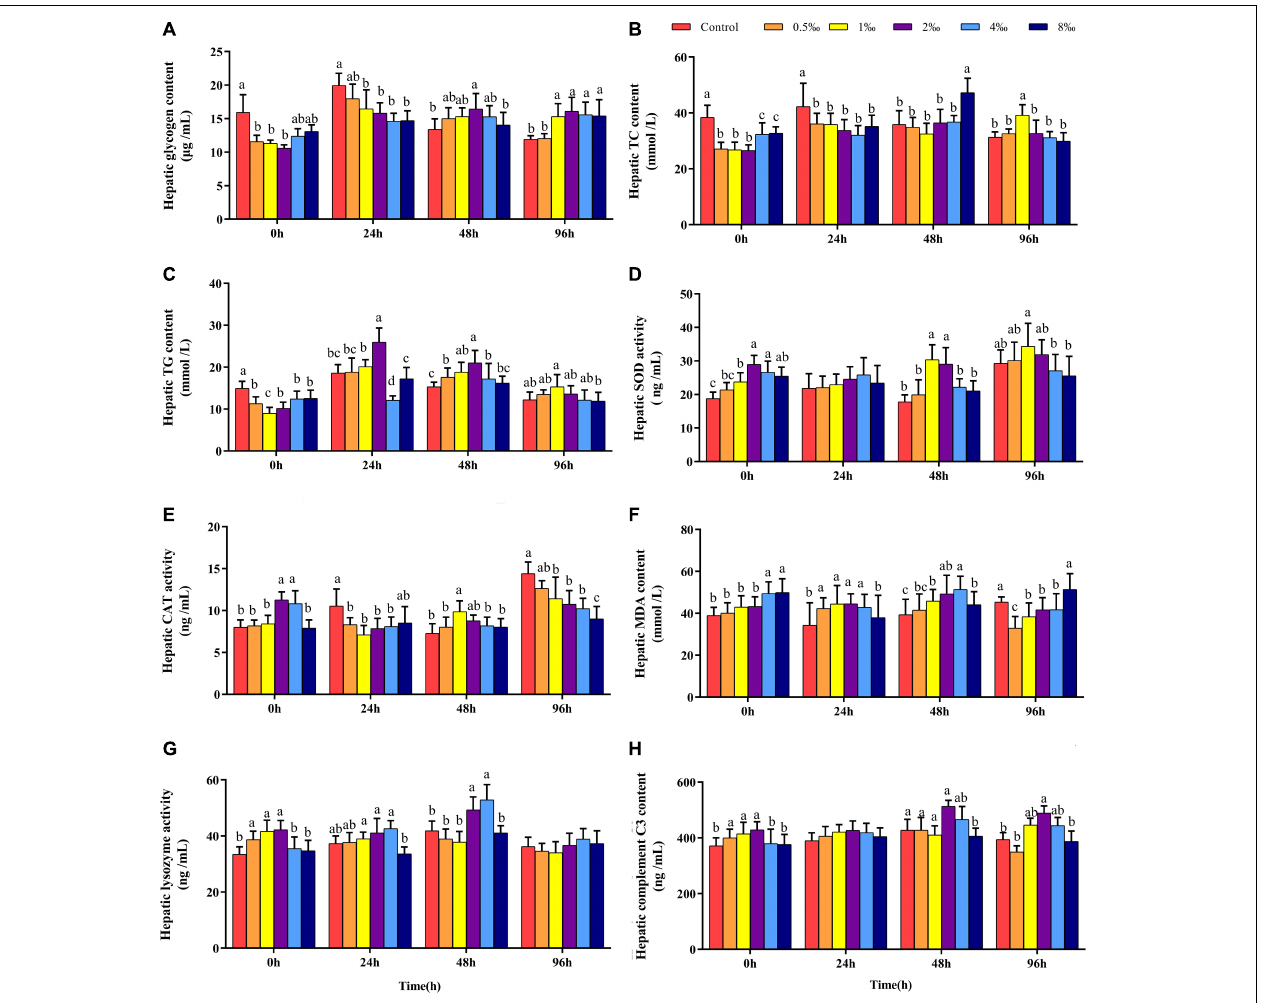
FIGURE 3 | Hepatic biochemical parameters of GIFT infected with S. iniae after being fed different APS levels. (A–H) Represent the control, 0.5, 1, 2, 4, and 8 multiple range test; P < 0.05).